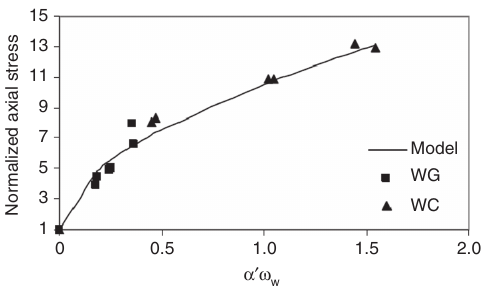
Figure 14 Normalized ultimate lateral strain versus lateral jacket stiffness.